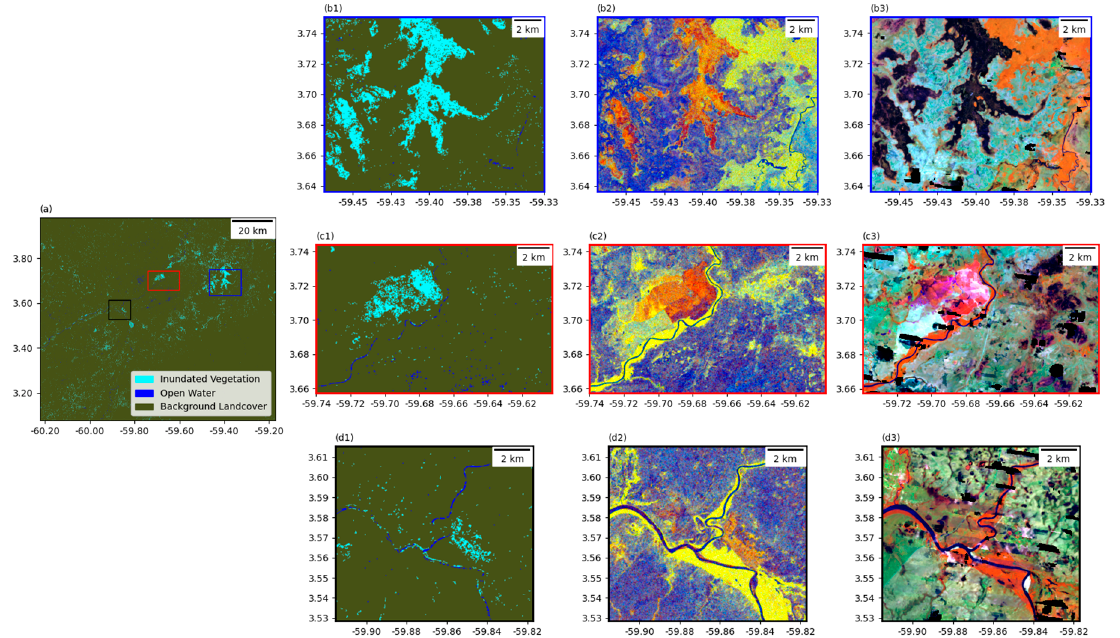
Figure 10. Example of RadWet dry season classified output over the North Rupununi dated 28 March 2017 ( a ). Subset figures represent the RadWet classified output, at representative locations including Sentinel-1 imagery used for the classification, and reference Sentinel-2 optical image. Specifically, ( b1 – b3 ) covers a section ofAmoko Lake; ( c1 – c3 ) shows the Irend River, including agricultural